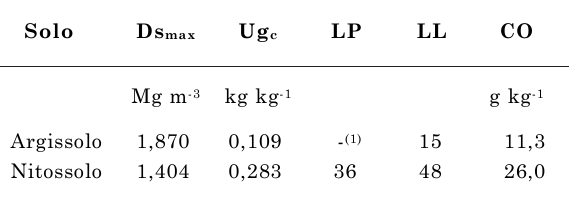
Quadro 2. Valores médios da densidade máxima (Ds ), umidade crítica (Ug ), limite de max c plasticidade (LP), limite de liquidez (LL) e teor de carbono orgânico (CO) do Argissolo Vermelho-Amarelo arênico e do